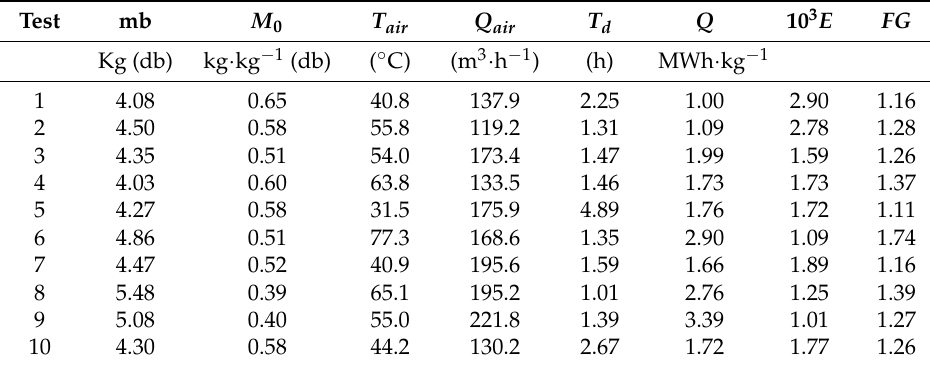
Table 1. Experimental results of drying